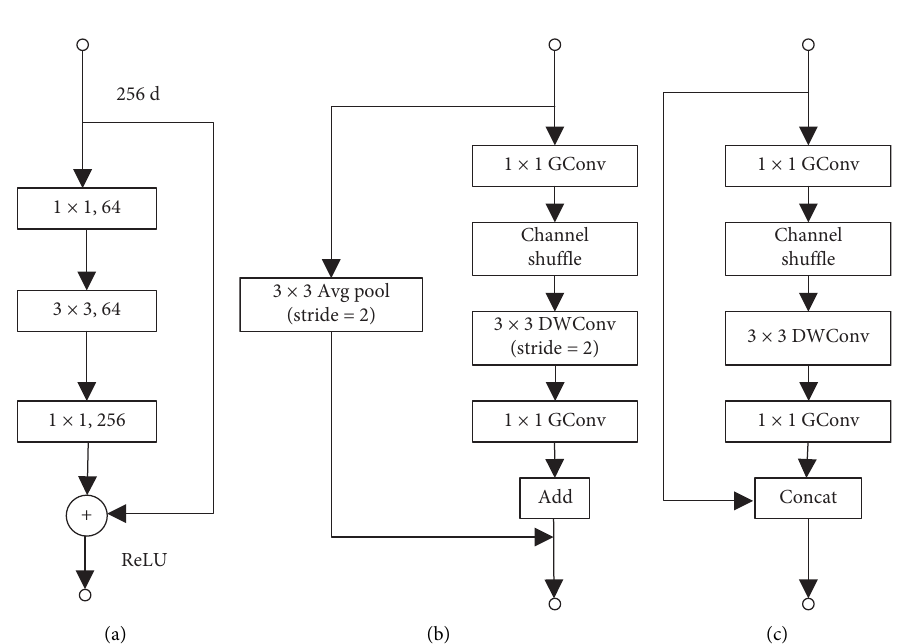
Figure 2: Bottleneck and ShuffleUnit [12, 14], (a) ResNet bottleneck, (b) ShuffleUnit1, and (c)